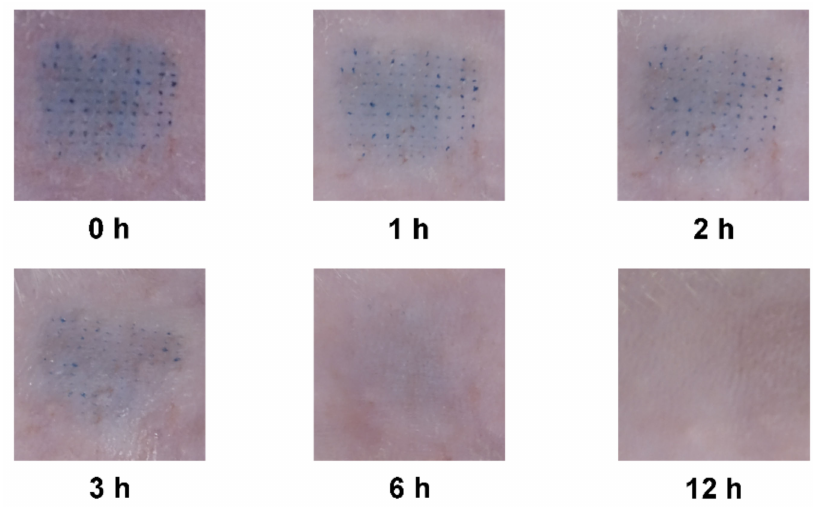
Figure 6. The recovery of abdominal skin in SD rat after treatment by the